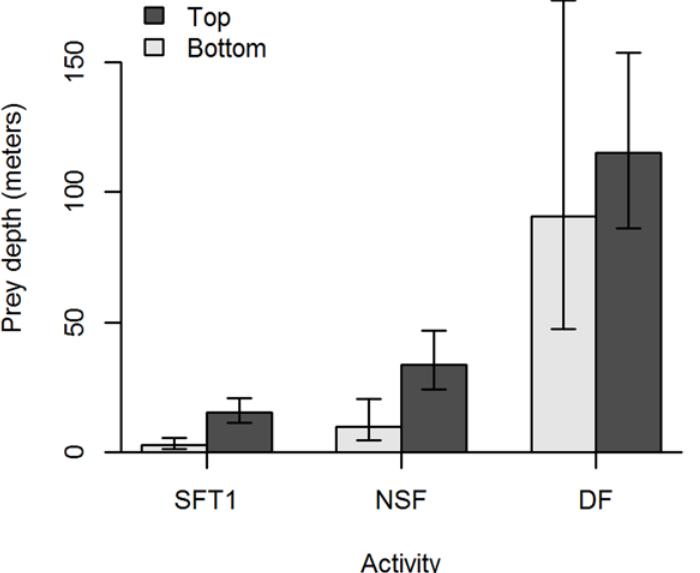
Fig 1. Back transformed prey layer depth recorded near minke whales during three different feeding activities. The depth at the top (dark grey) and bottom (light grey) of the prey layer is shown. SFT1 = surface feeding tactic I, NSF = near-surface foraging, DF = deep foraging. Error bars represent 95% confidence intervals. N =